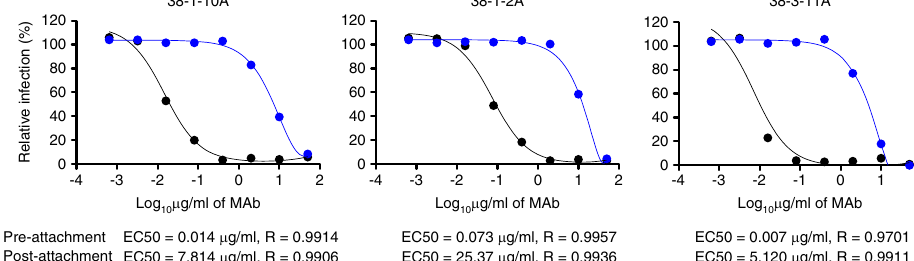
the virus with a stoichiometry of 60 Fabs per virus particle (Fig. 4). The density for the Fab in the EV71/38-1-10A complex is weaker and has lower resolution than that for the viral capsid, suggesting that not all of the binding sites are occupied. However, most of the side chain orientations of the Fab at the interface with the virus are de fi ned by the density at a lower contour level (Supplementary Fig. 9). To enable the model of the Fab and its interactions with the virus to be accurately modelled, we